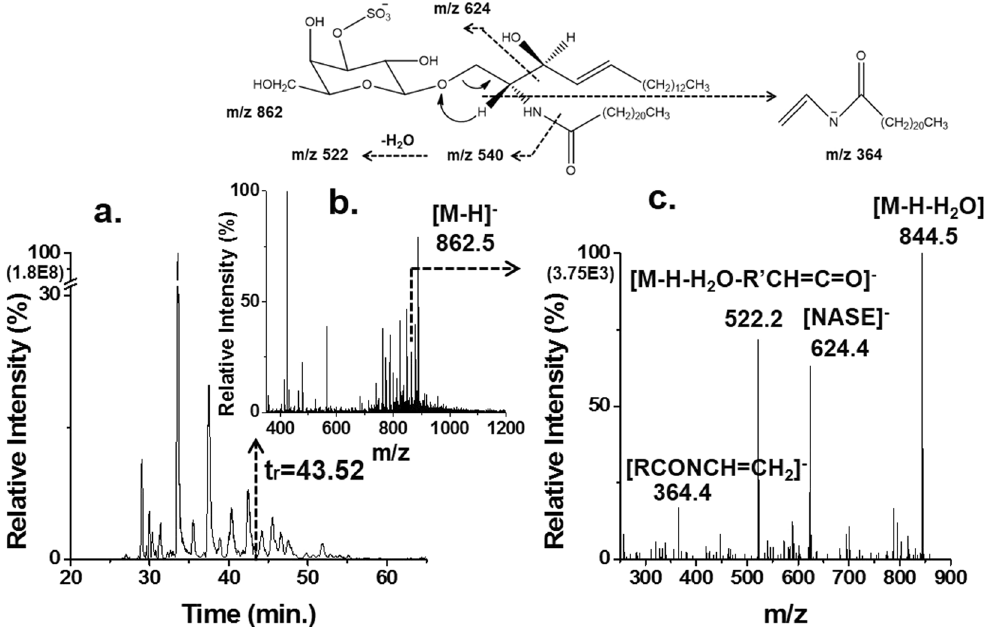
Figure 1. Determination of the molecular structure of a sulfatide by nLC-ESI-MS/MS. ( a ) Base peak chromatogram (BPC) of lipid extract of the gastrocnemius (Gas) tissue from wilde type (WT) mice, ( b ) a precursor scan MS spectrum at t r = 38.40 min, and ( c ) the corresponding CID spectrum of m/z 862.5, [M-H] − , resulting in the identification of a sulfated galactosylceramide (sulfatide or ST), d18:1/22:0-ST by nLC-ESI-MS/